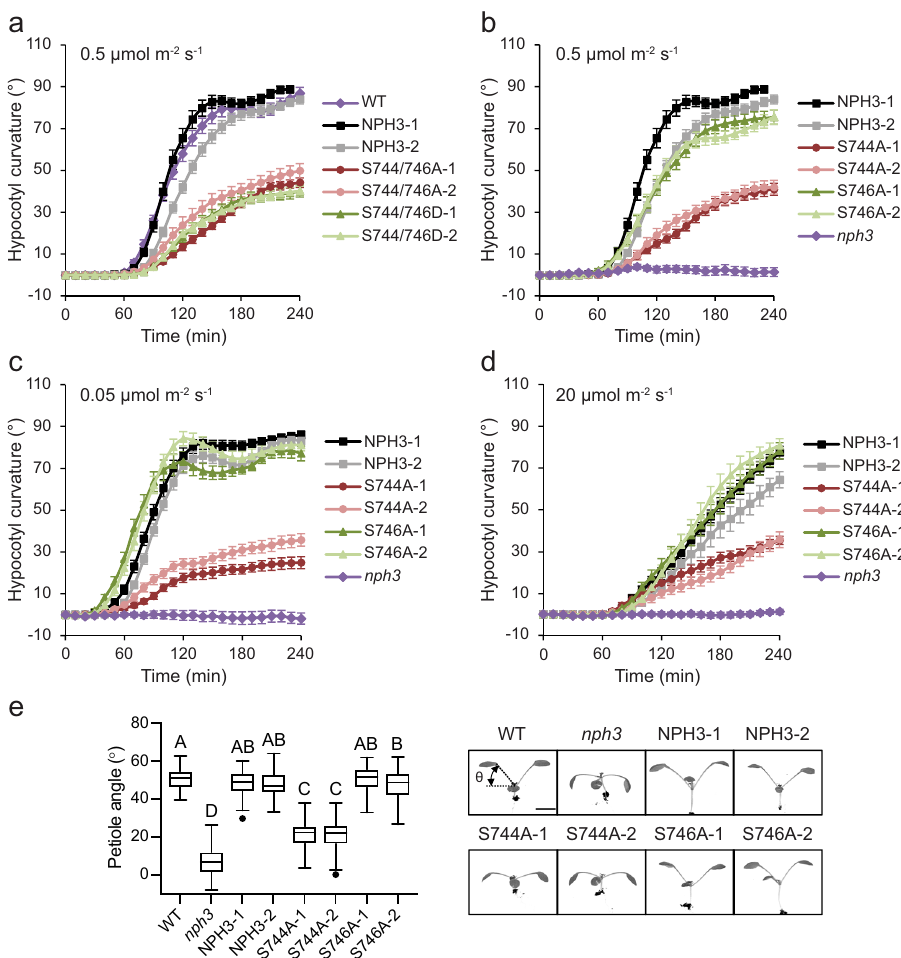
Fig. 6 Phot1 phosphorylation of NPH3 promotes functionality. a Phototropism of etiolated wild-type (WT) seedlings, nph3 seedlings expressing GFP- NPH3 (NPH3) or phosphorylation site mutants S744A S746A and S744D S746D irradiated with 0.5 µ mol m − 2 s − 1 unilateral blue light. b – d Phototropism of etiolated nph3 seedlings expressing GFP-NPH3 (NPH3), phosphorylation site mutants S744A or S746A and nph3 mutant seedling irradiated with b 0.5 µ mol m − 2 s − 1 , c 0.05 µ mol m − 2 s − 1 or d 20 µ mol m − 2 s − 1 unilateral blue light. Hypocotyl curvatures were measured every 10 min for 4 h, and each value is the mean ± SE of 17 – 20 seedlings from two independent biological replicates. Exact n values are provided in the Source data fi le. e Petiole positioning of WT, nph3 mutant and nph3 seedlings expressing GFP-NPH3 or phosphorylation site mutants S744A and S746A. Plants were grown under 80 µ mol m − 2 s − 1 white light for 9 d before transfer to 10 µ mol m − 2 s − 1 white light for 5 d. Box and whisker plots show petiole angle from the horizontal measured for the fi rst true leaves. The centre line indicates the median, the bounds of the boxes indicate the 25th and 75th percentiles, whiskers extend 1.5 times the interquartile range and outliers are represented by dots. ( n = 60 seedlings, from three independent biological replicates). Different letters denote signi fi cant differences ( P < 0.01, one-way ANOVA with Tukey post test). Exact P values are provided in the Source data fi le. Representative images for each genotype are shown on the right. Bar, 5